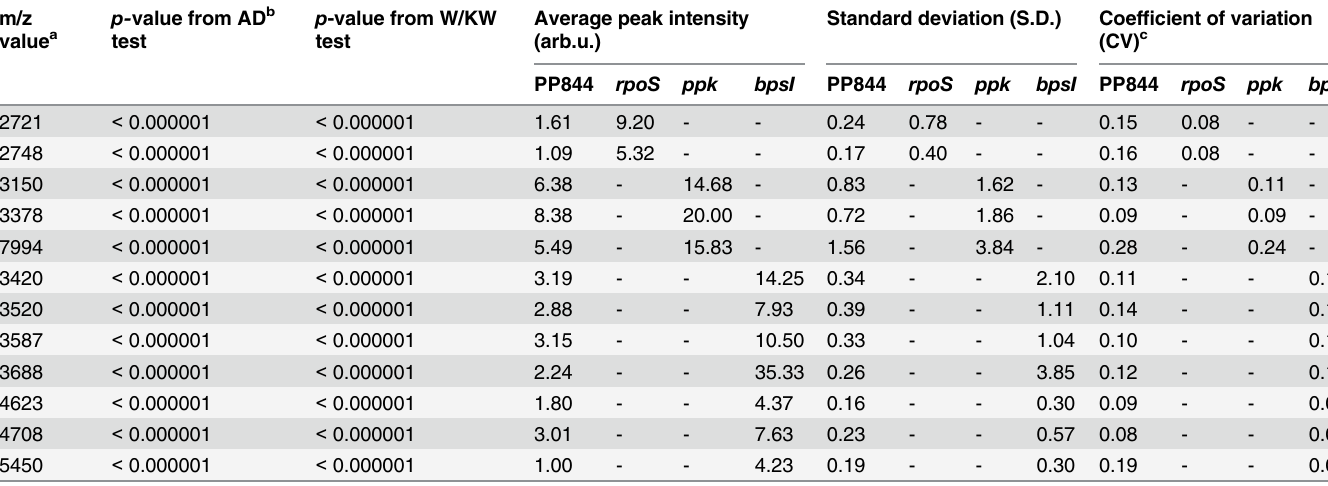
Table 1. Candidate biomarkers of B . pseudomallei mutant